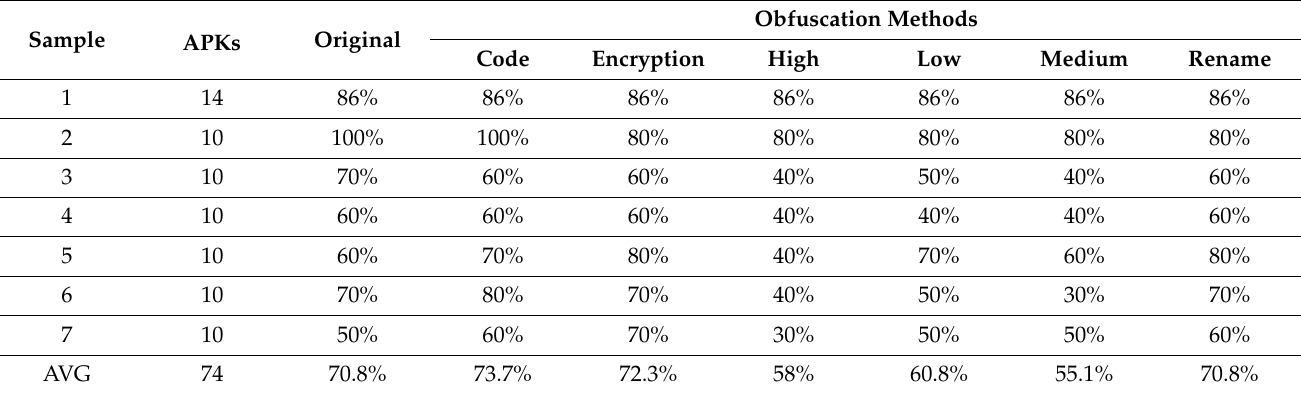
Table 11. Executability of APK samples checked with Strace tool in Android